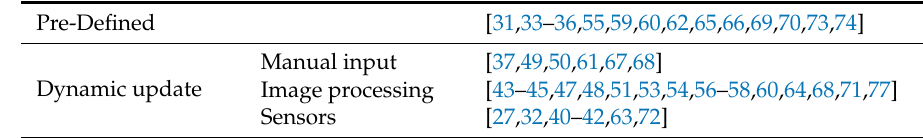
Table 8. Simulation result updating in selected studies.